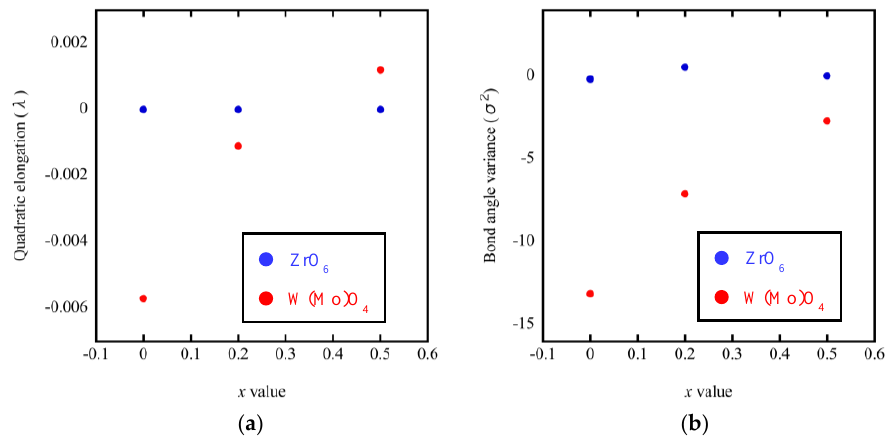
Figure 12. Quadratic elongation ( a ) and bond angle variance ( b ) of ZrO 6 and W(Mo) 2 O 8 polyhedra in ZrW 2− x Mo x O 8 .